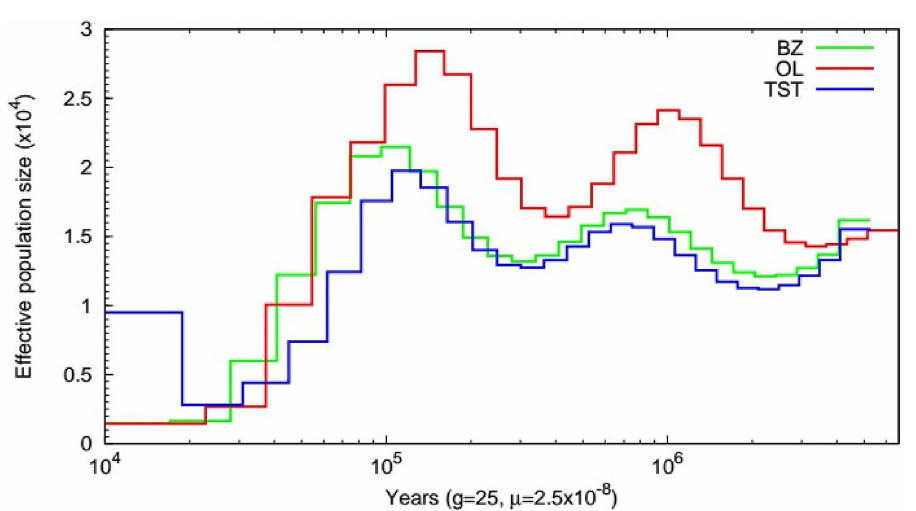
Figure 3. Demographic history of the sheep populations. PSMC analysis results for the representative individuals sequenced at a high read coverage (~ 42×) exhibit inferred variations in Ne over the last 10 6